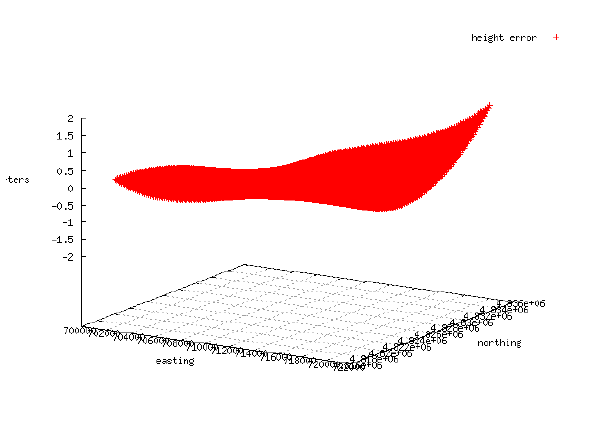
Figure 2 Polynomial approximation of the height errors